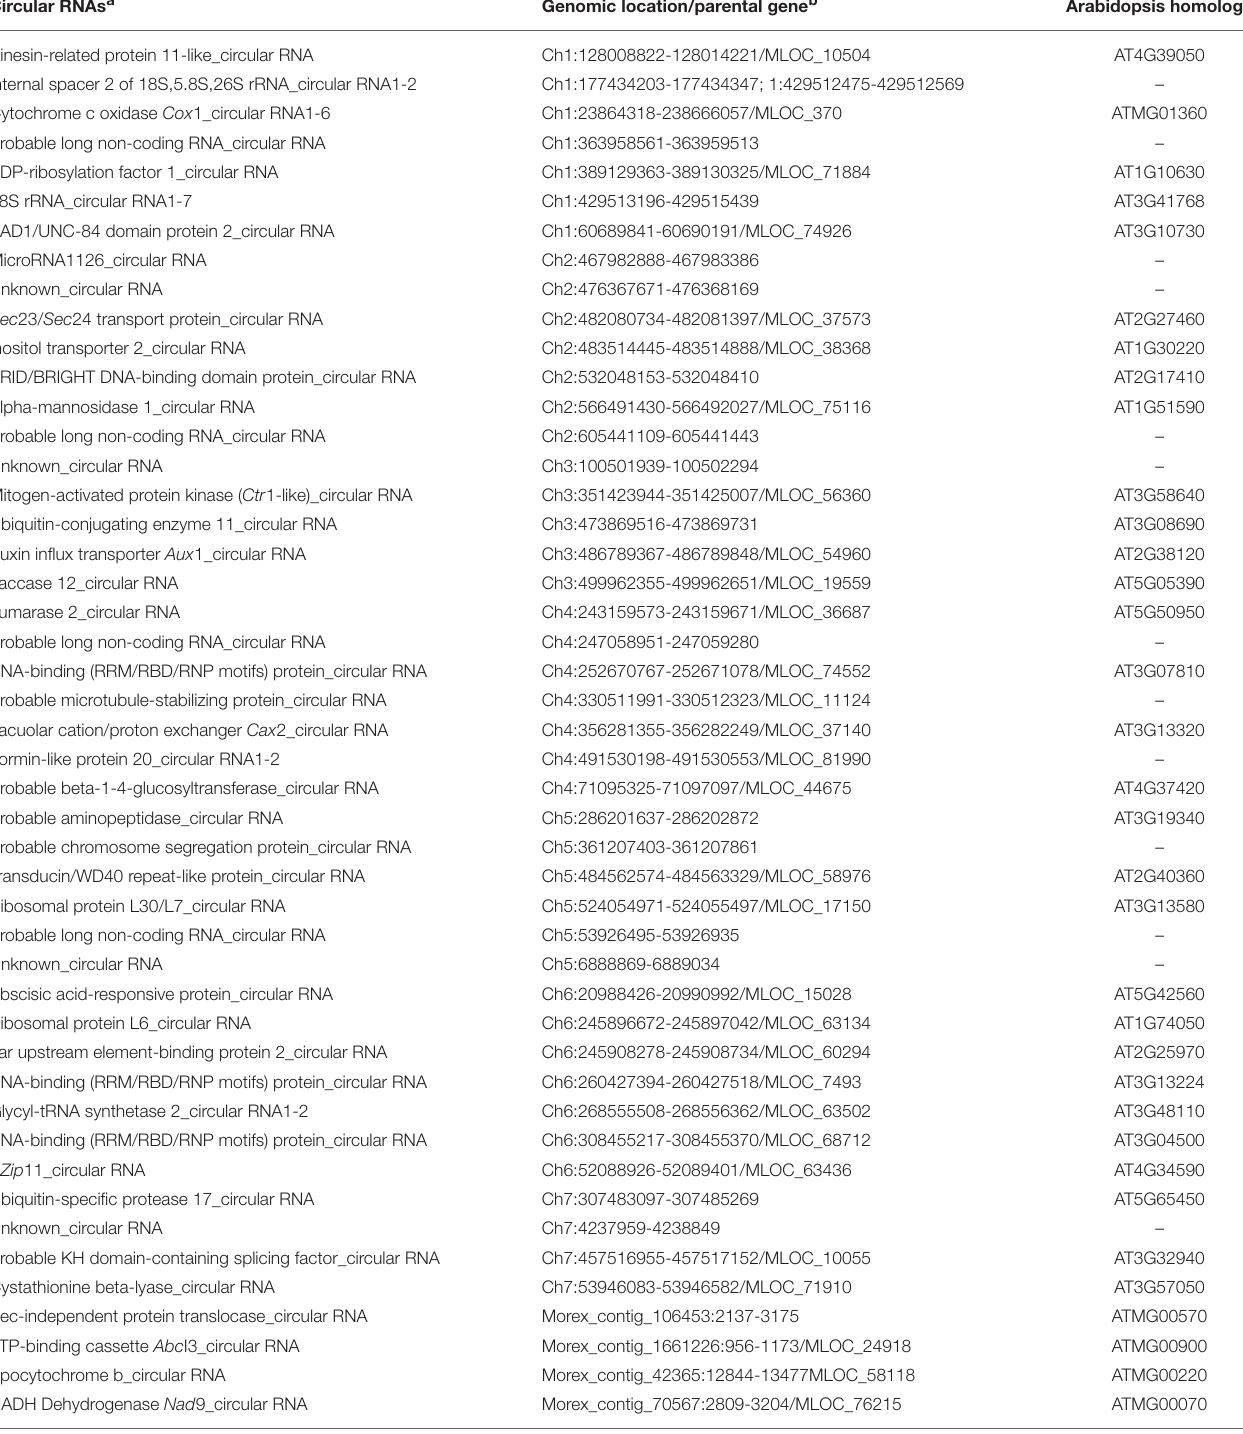
TABLE 1 | Barley transfer cell-specific circular